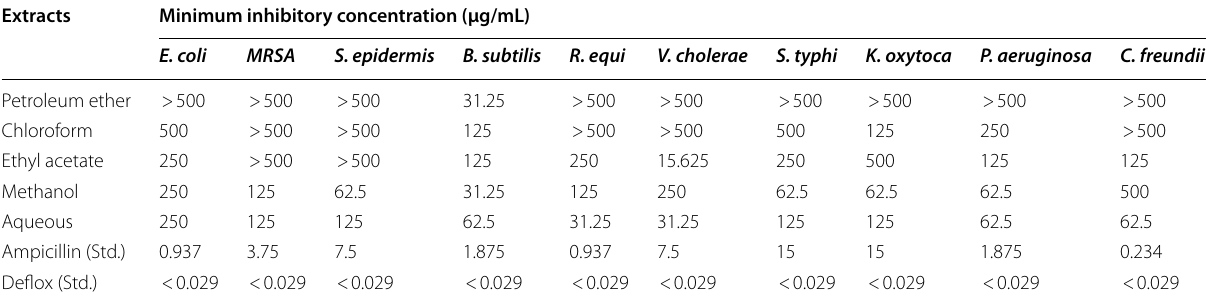
Table 3 Minimum inhibitory concentration of E. ramosissimum leaf extracts against the selected pathogenic bacteria Extracts Minimum inhibitory concentration